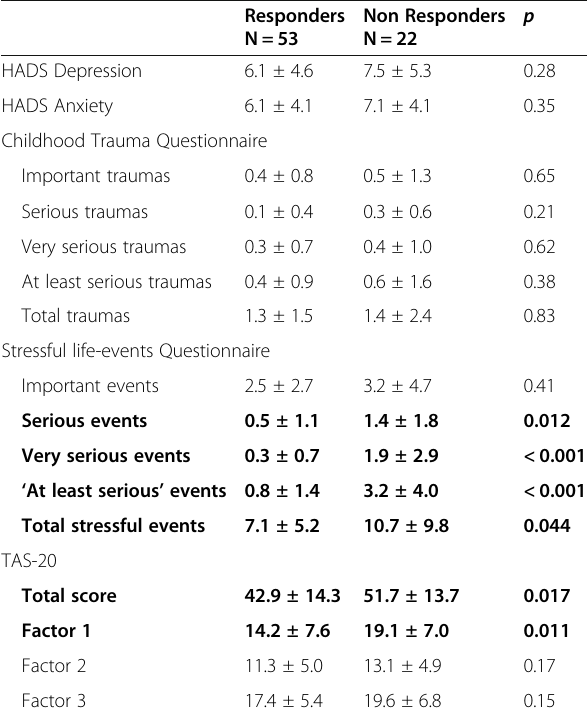
Table 3 Psychological characteristics of the two groups as result from self-reported questionnaires at the baseline evaluation. Data are presented as “ mean ± standard deviation ”